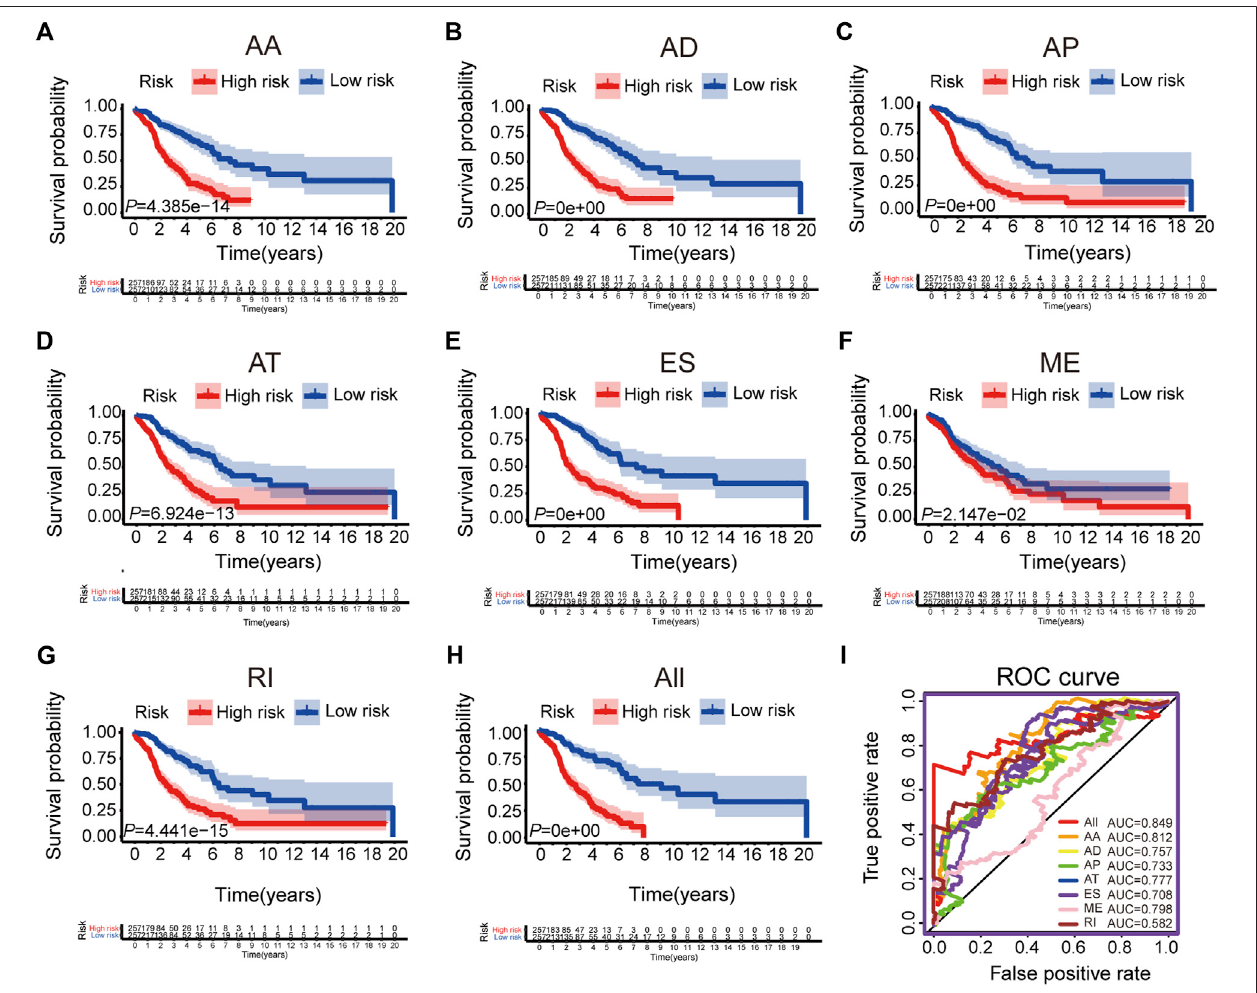
FIGURE 2 | The Kaplan-Meier curves and ROC curves of prognostic AS models. (A – G) The Kaplan-Meier plots of seven types of AS events, respectively. (H) The Kaplan-Meier plots of combined prognostic model. (I) The ROC curves for overall survival of seven types of AS events and combined prognostic model.